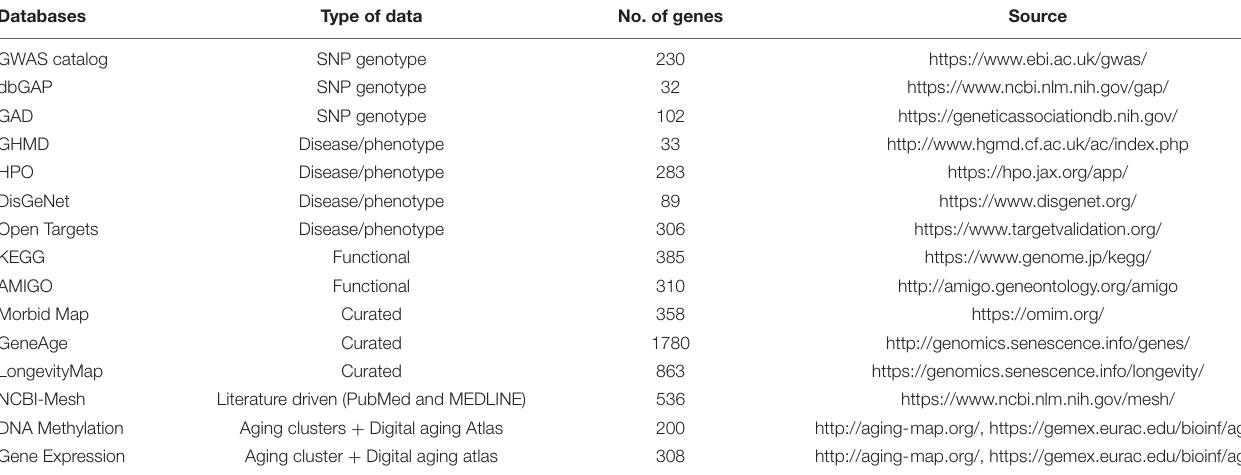
TABLE 1 | Databases used for aging and longevity associated genes curation.